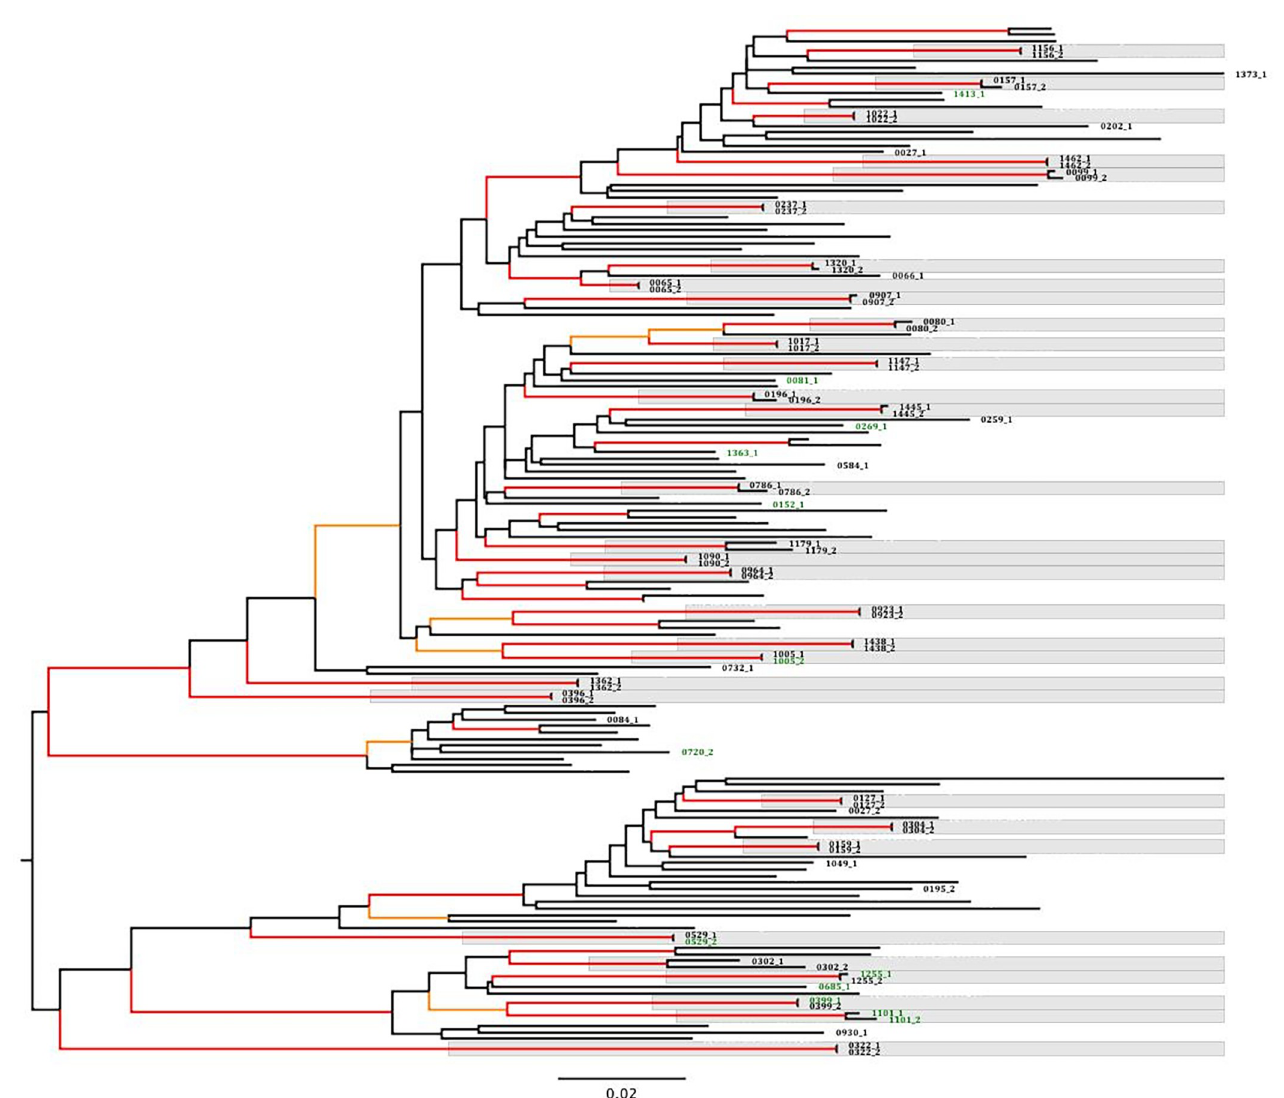
Fig 2. Phylogenetic tree of 83 pre-treatment HIV-1 consensus sequences collected at the first and/or second time points from HAART na ï ve participants (N = 50). Phylogenetic tree constructed from consensus fasta files by Maximum-likelihood estimation using the GTR model of nucleotide substitution with gamma distributed rate heterogeneity and approximate likelihood ratio test Shimodaira-hasegawa (aLRT-SH) branch support assessment. Local ‘reference’ sequences (taxa not labelled, n = 78) included. Branches leading to nodes with aLRT-SH support of > 0.90 and > 0.95 are coloured orange and red respectively. Individual sequences are labeled in bold letters ending with 1 (first time point) or 2 (second time point). Sequences with at least one surveillance HIV drug resistance mutation detected at > 2% frequency by next generation sequencing are coloured in green. Sequence pairs from the same participant shaded in grey.